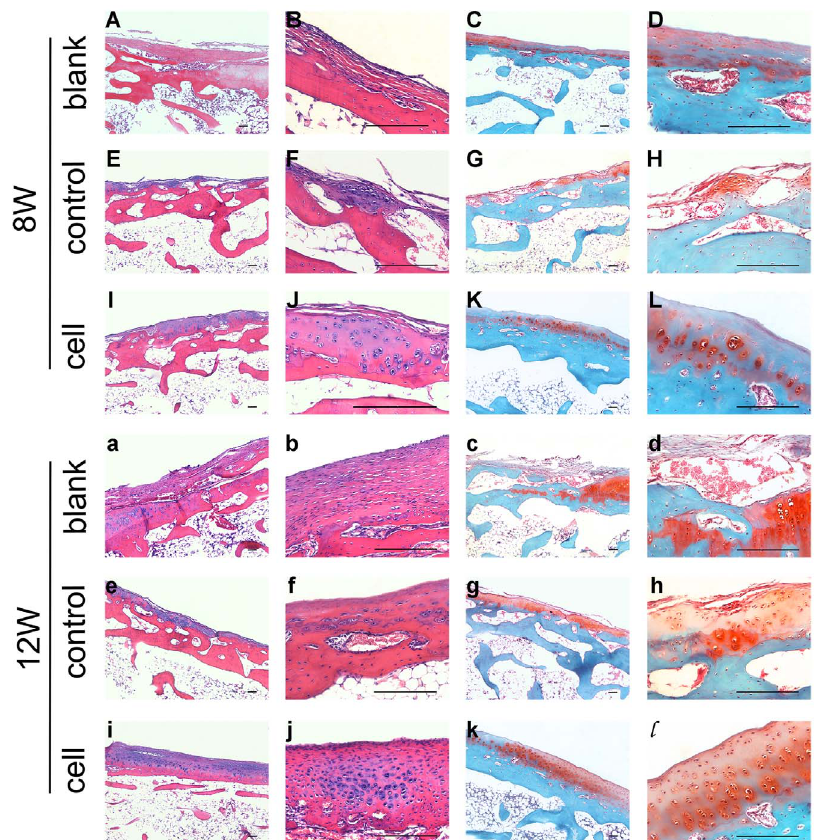
Figure 4. Histological evaluation of scaffolds and iPSCs in the restoration of cartilage defects at 8 weeks (A–L) and 12 weeks (a–l). Blank group ( A–D, a–d ) defects were filled with fibrocartilage, while abundant cells were observed in the cell group ( I–L, i–l ). The H&E and safranin-O stained images in the right column are magnifications of images in the left column. All scale bars represent 200 m m.